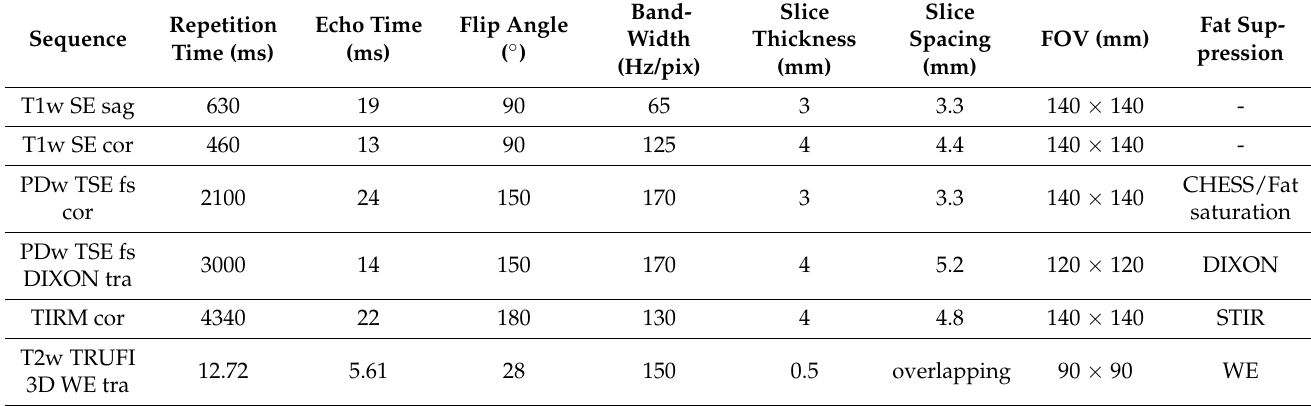
Table 1. MRI scanning